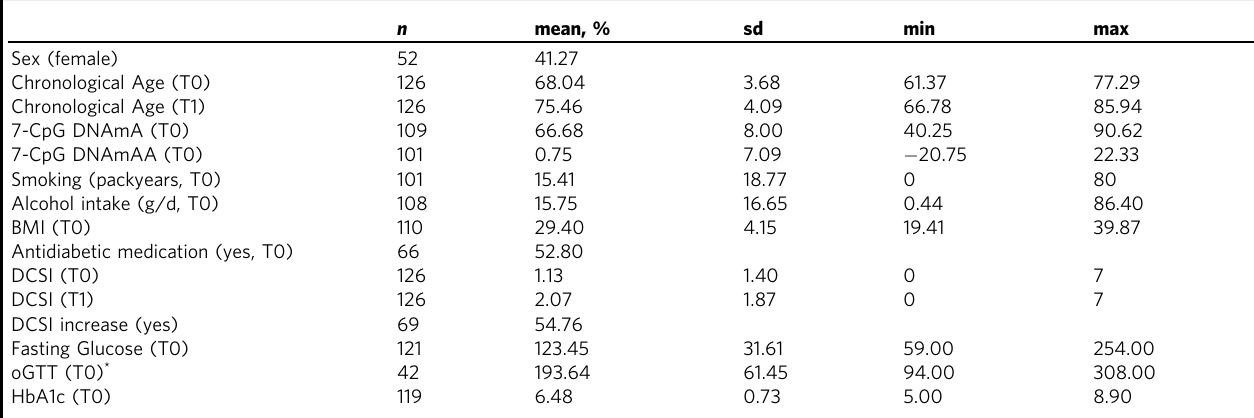
Table 1 Cohort characteristic of participants that were diagnosed with T2D at baseline and completed follow-up on average 7.4 years later ( n = 126). n mean, %